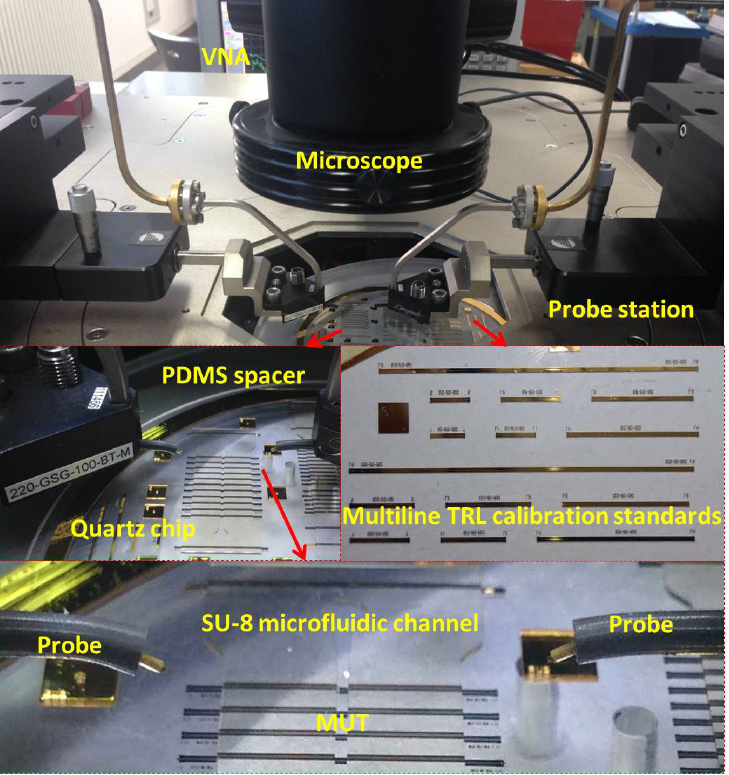
Figure 3. On-wafer measurement setup, including the probe station, the microfluidic sensing chip, and the multiline-TRL calibration